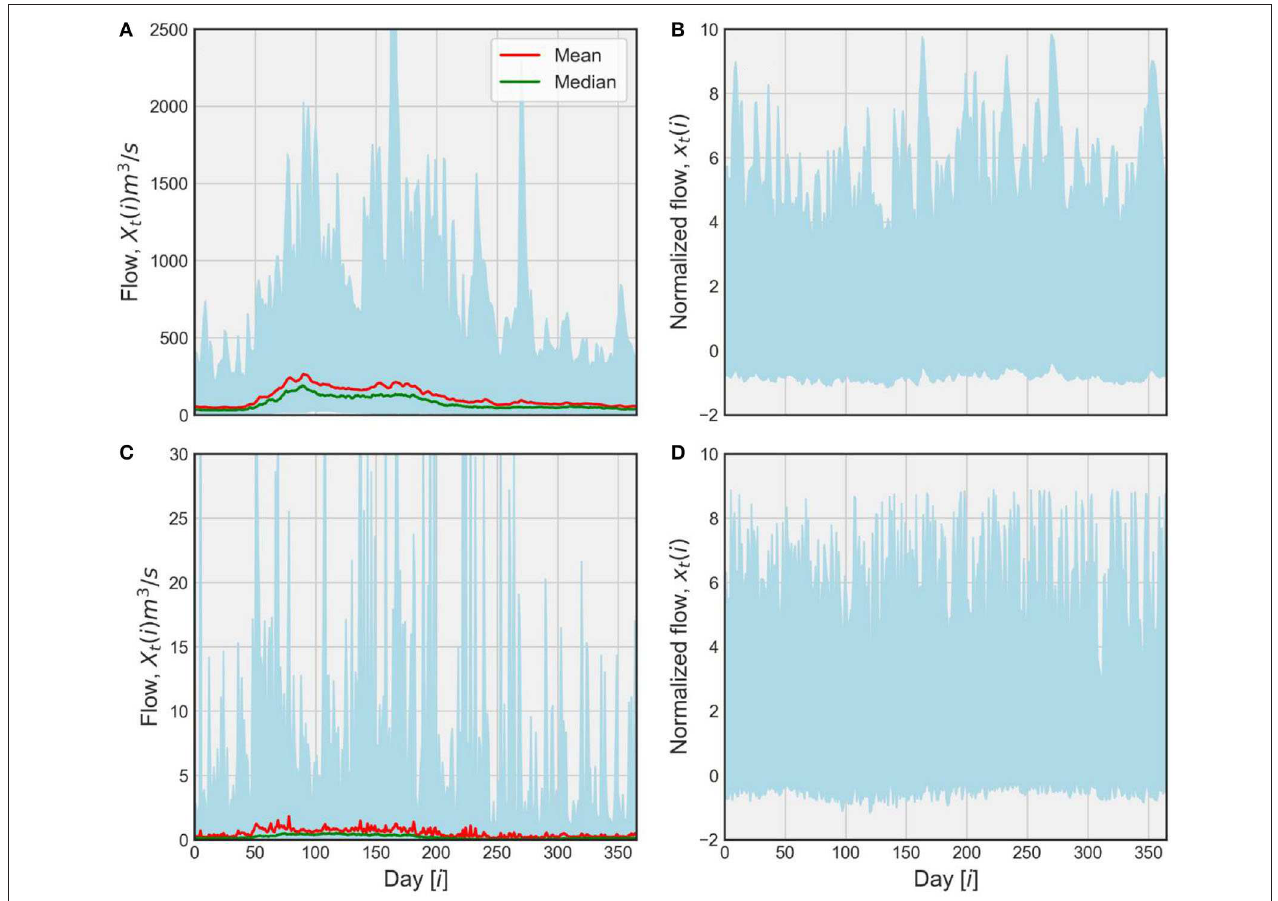
FIGURE 4 | Streamflow time series normalization for two basins. (A) Shaded envelope representing an ensemble of entire raw streamflow records, X t ( i ), at a daily scale for the Cedar River at Cedar Rapids (16,800 km 2 ). This envelope shows the variability of streamflow, σ ( i ), while the red and green lines represent mean, µ ( i ), and median of flows, respectively. (B) Shaded envelope representing an ensemble of normalized streamflows, x t ( i ), corresponding to (A) . (C) Raw streamflow time series at Rapid Creek near Iowa City (70 km 2 ) with same description as (A) . (D) Normalized streamflow time series corresponding to (C) .